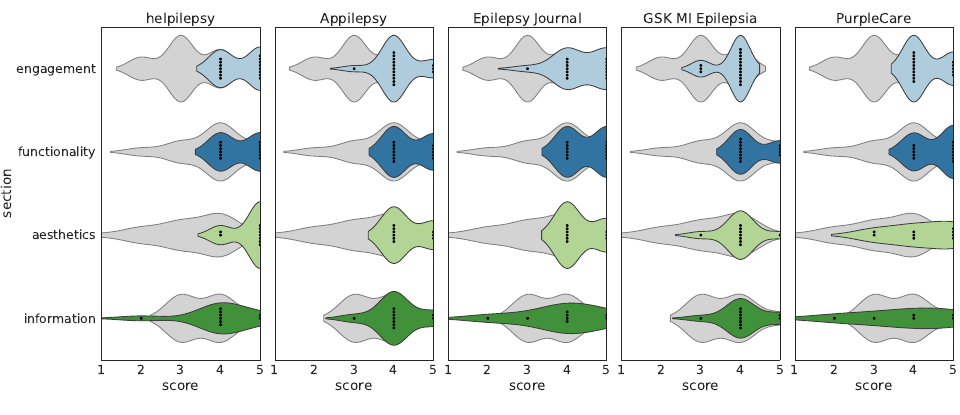
Figure 5. Section scores for top 5 iOS